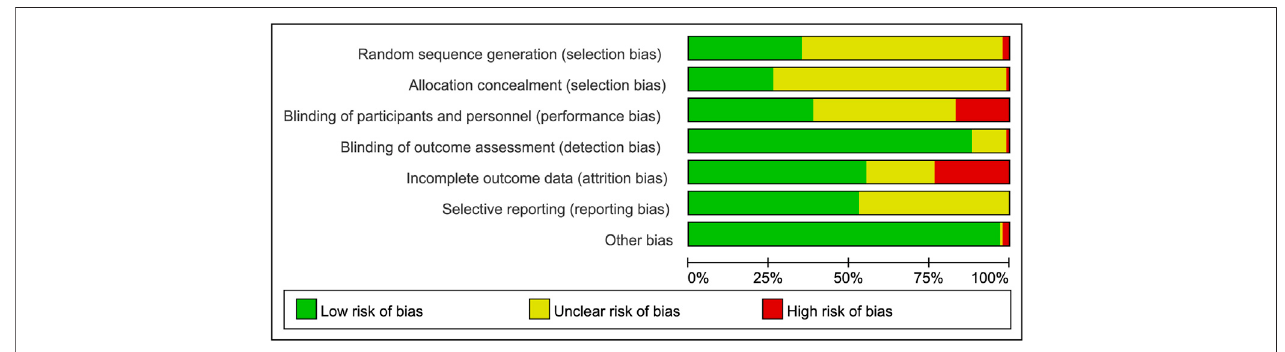
FIGURE 3 | Risk of bias